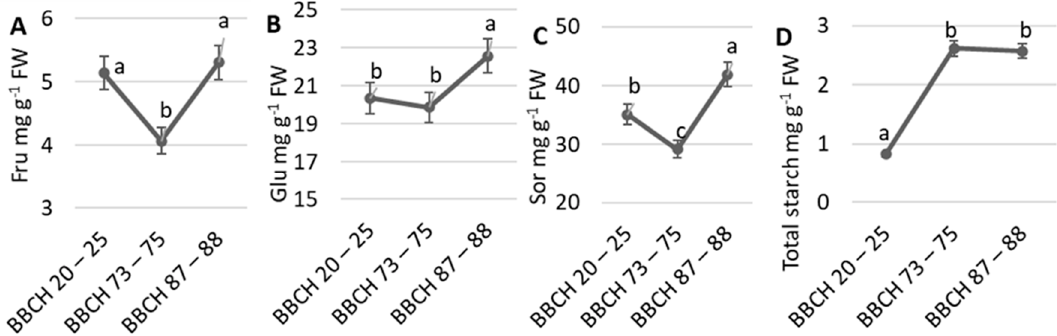
Figure 6. E ff ect of seasonality distances between trees on accumulation of fructose ( A ), glucose ( B ), sorbitol ( C ) and total starch ( D ). The data presented as an average of four planting distances. The di ff erent letters in graphics indicate significant di ff erences. The data were processed using analysis of variance (Anova), the Turkey (HSD) test at the confidence level p = 0.05. No significant di ff erences were found in the amount of fructose and sorbitol depending on distances between apple trees. The highest contents of glucose were found in apple tree leaves planted at 0.75 m (Figure 7A–C). The decreased distance up to 4 times (from 1 m to 0.25 m) resulted the decrease of total starch up to 37–53% (Figure